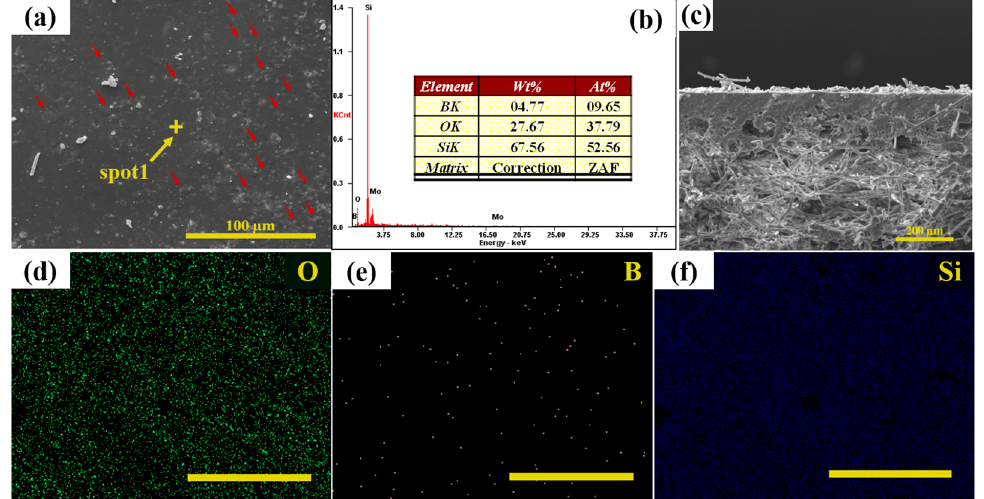
Figure 8. ( a ) Surface SEM image of the as-prepared coating; ( b ) the EDS analysis of spot 1; ( c ) cross-section SEM images of the coating; ( d – f ) the EDS mappings of the coating surface. Sintering parameters: Inserting temperature: 1100 °C, heat rate: 10 °C/min, sintering temperature: 1200 °C, holding time: 0.5 h, and cooling down with the furnace.